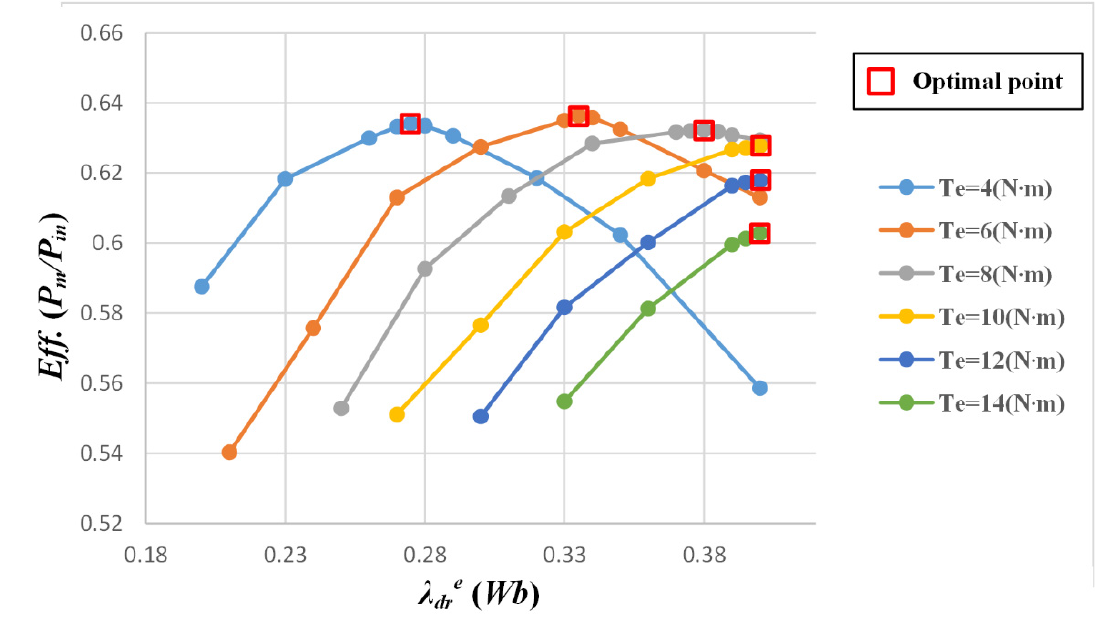
Figure 10. Experimental results of efficiency (P out /P in ) of a DIFWM according to the adjusted rotor flux.